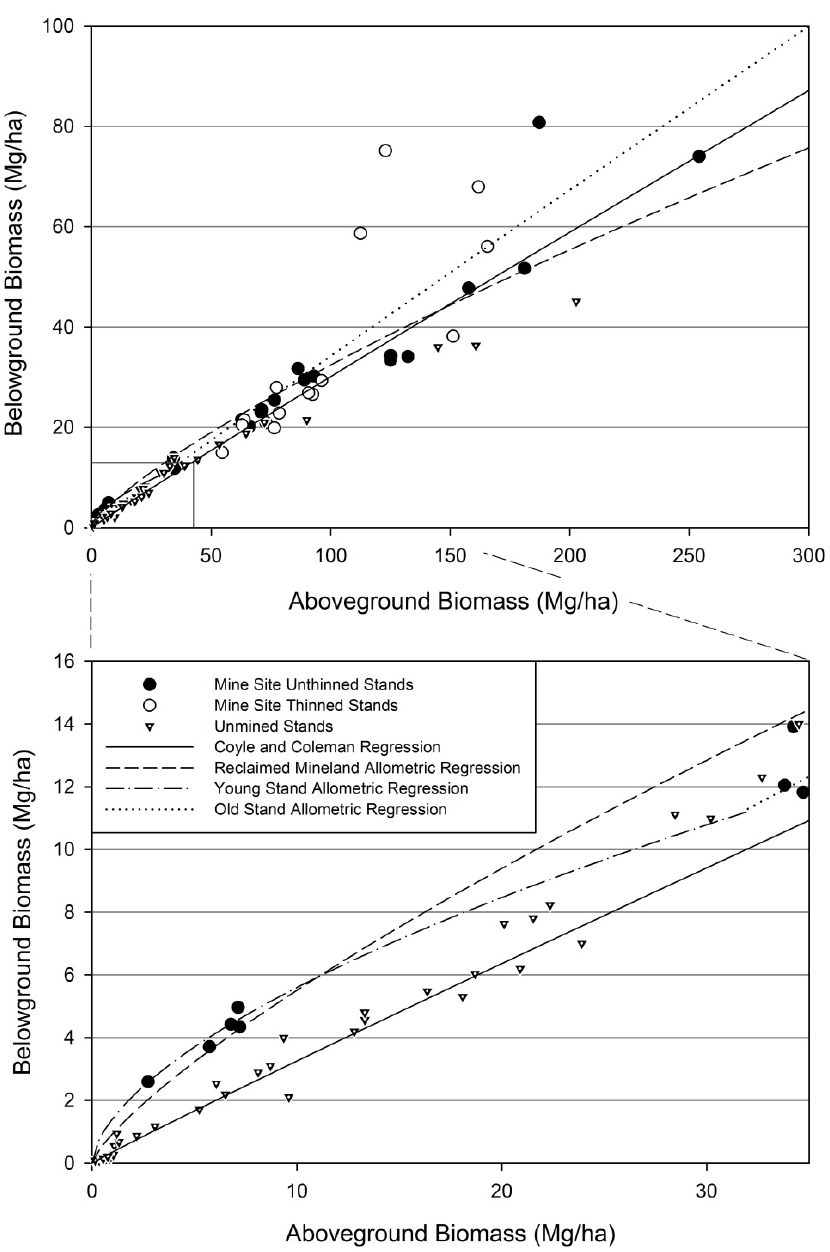
Figure 12. Untransformed stand level biomass data for loblolly pine on reclaimed mineland and unmined sites [25]. Inset reveals distinct biomass partitioning differences for young stands. Log-linear allometric regressions displayed here on an untransformed